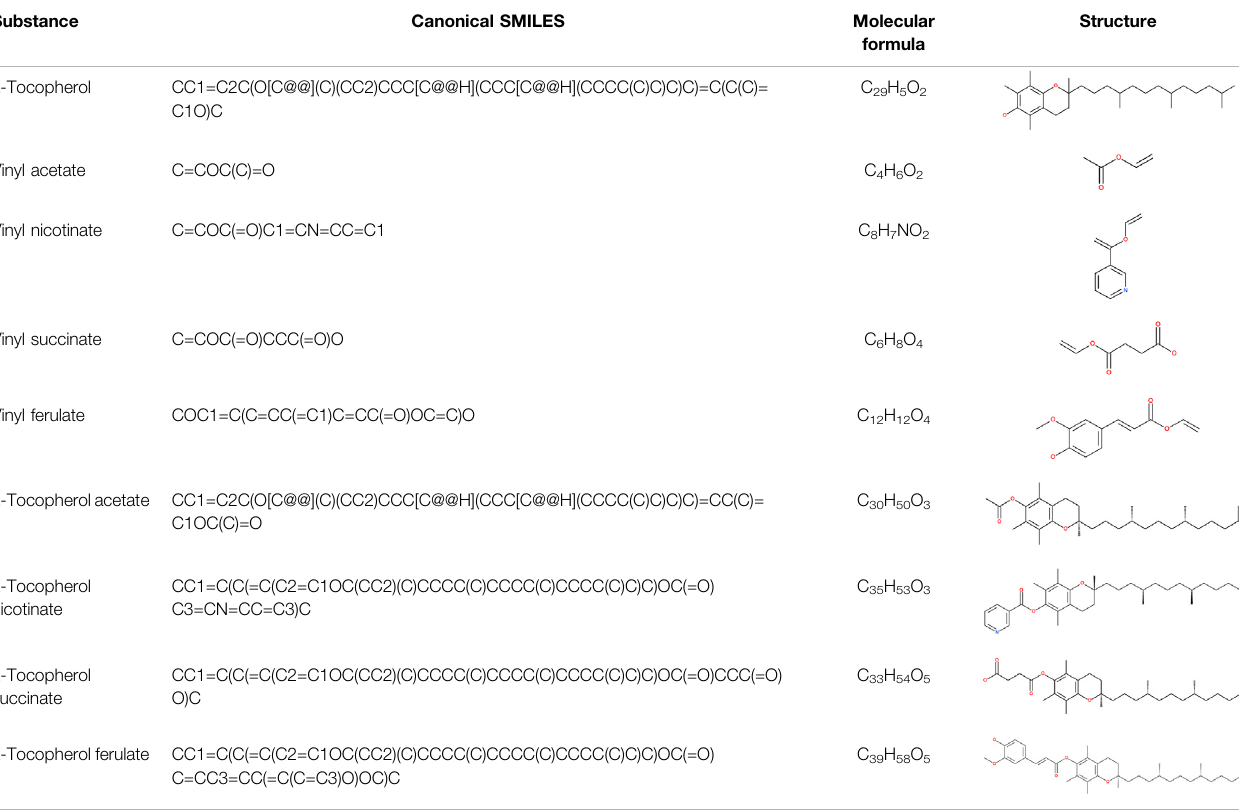
TABLE 2 | SMILES codes for binders and products, molecular formula, and structure of the substances applied in this study. Substance Canonical SMILES Molecular